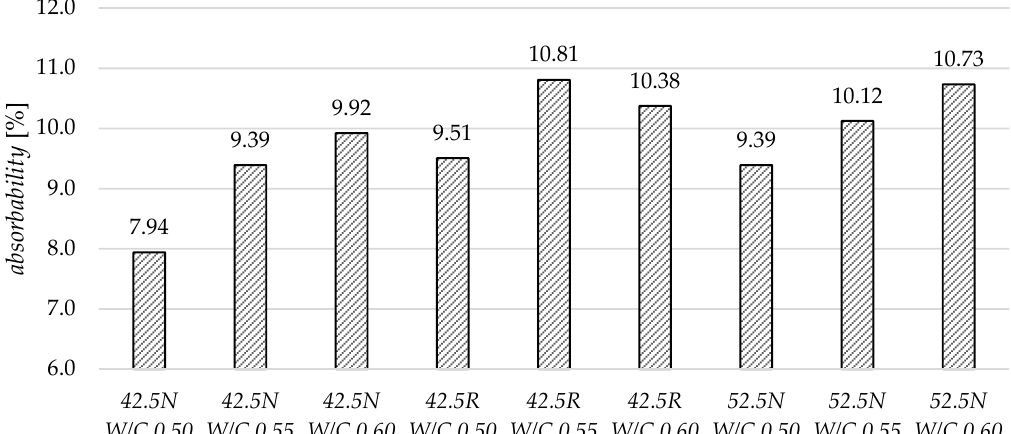
Figure 4. The comparison of specimens’ water absorbability.